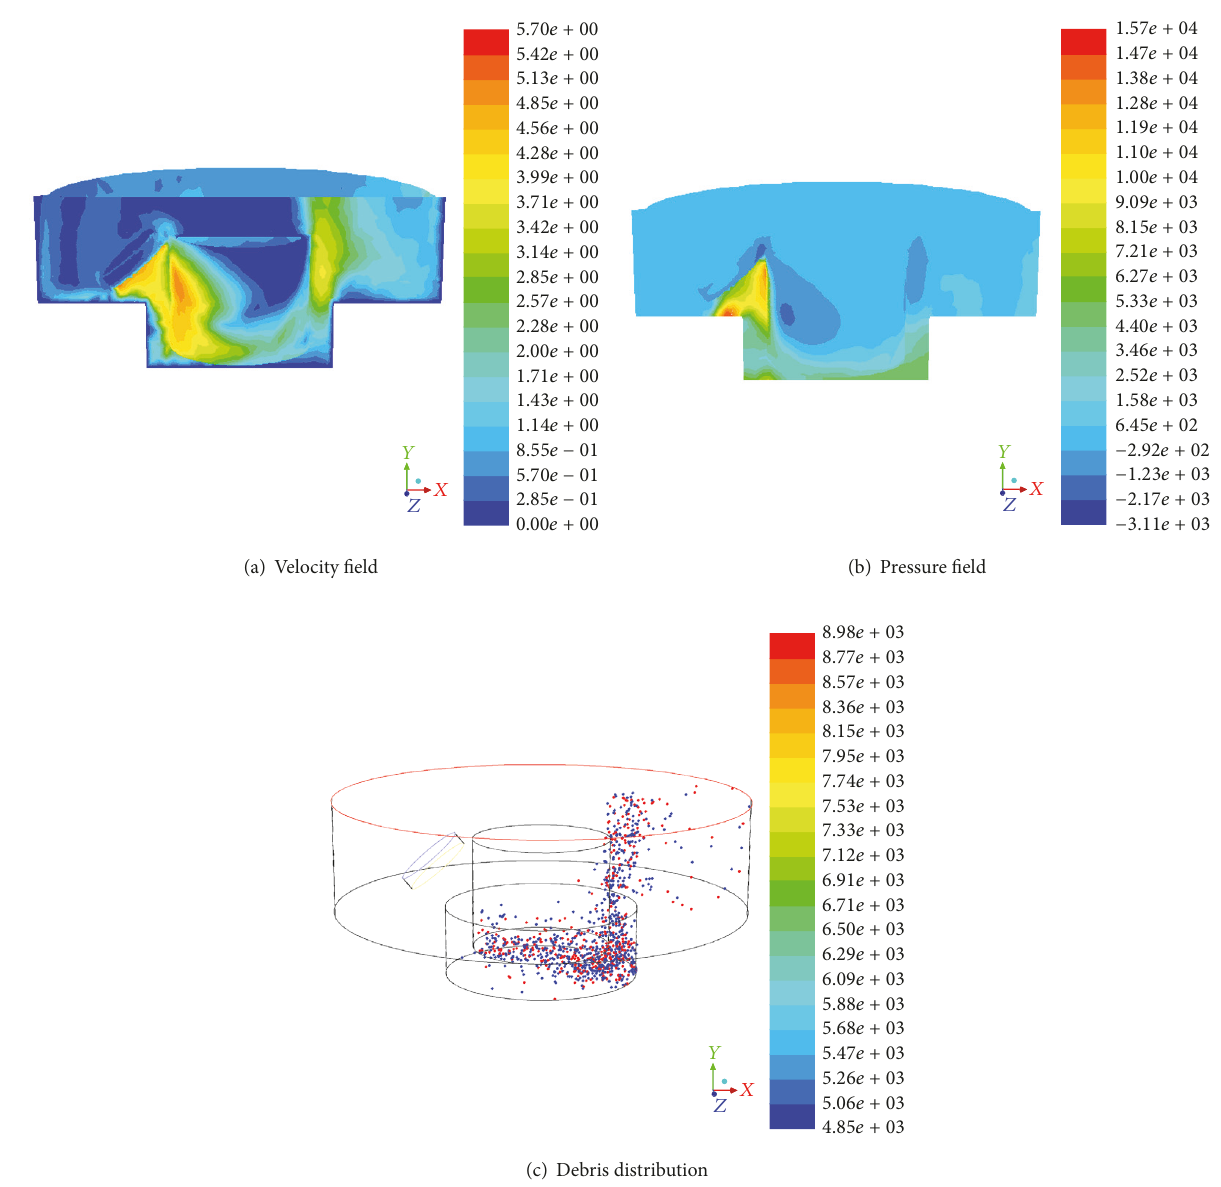
Figure 7: Schematics of gap flow field with flushing at 5m/s and 0.5 mm deep